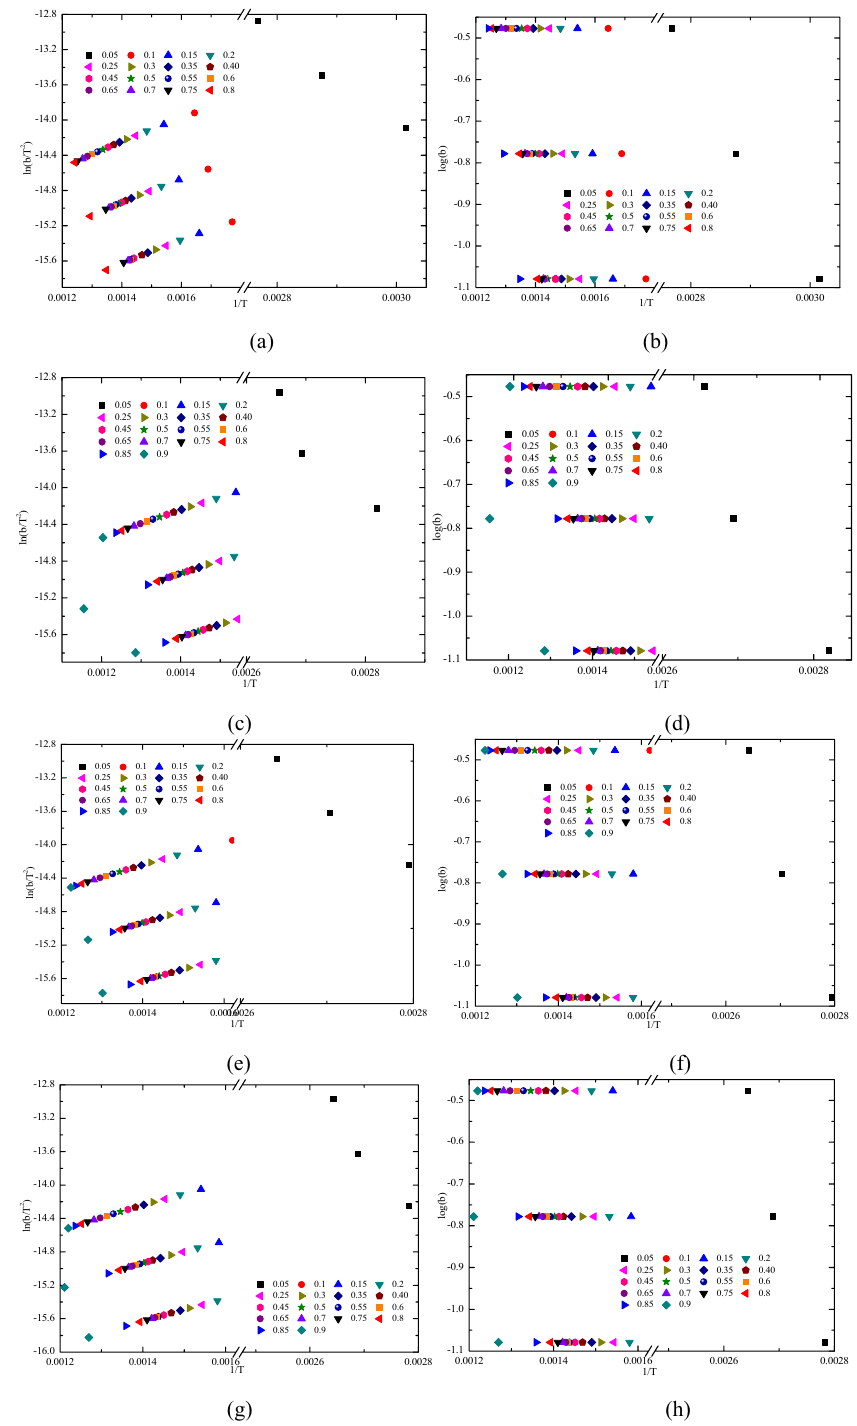
Figure 10. Fitting calculation process of activation energy at different reaction rates. ( a ) R C with the KAS method, ( b ) R C with the OFW method, ( c ) Sad-8 h with the KAS method, ( d ) Sad-8 h with the OFW method, ( e ) Sad-24 h with the KAS method, ( f ) Sad-24 h with the OFW method, ( g ) Sad-48 h with the KAS method, and ( h ) Sad-48 h with the OFW